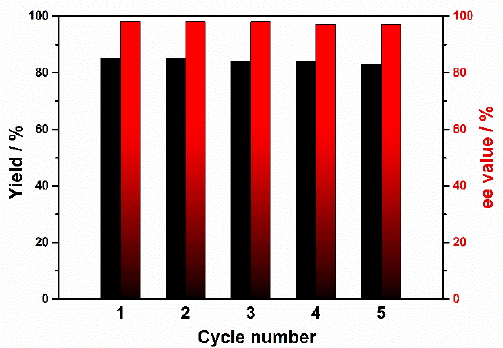
Figure 1. The recycling of the SBA-15-AEP catalyst in the aza-Michael–Henry cascade reaction between 2-aminobenzaldehyde and β